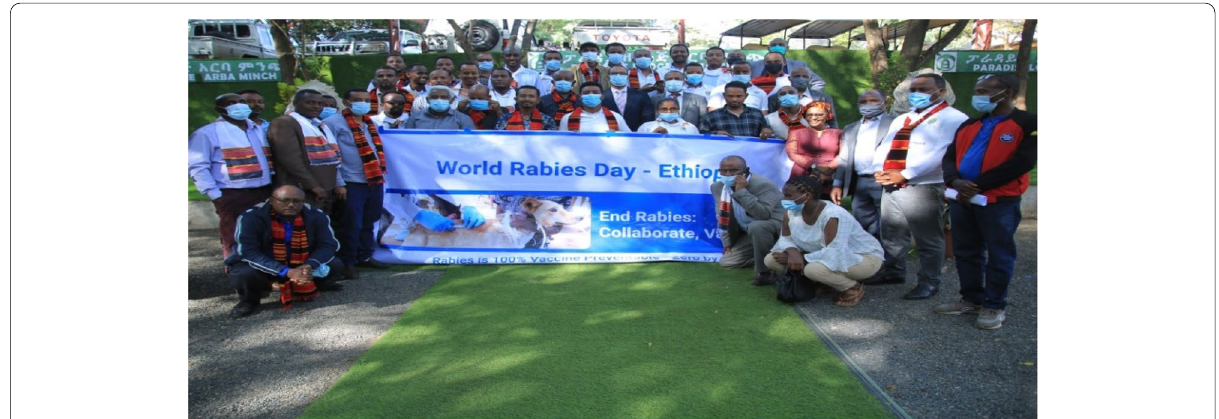
Fig. 9 Moment of World Rabies Day Celebration in Ethiopian, 2021 September 28(Ministry of